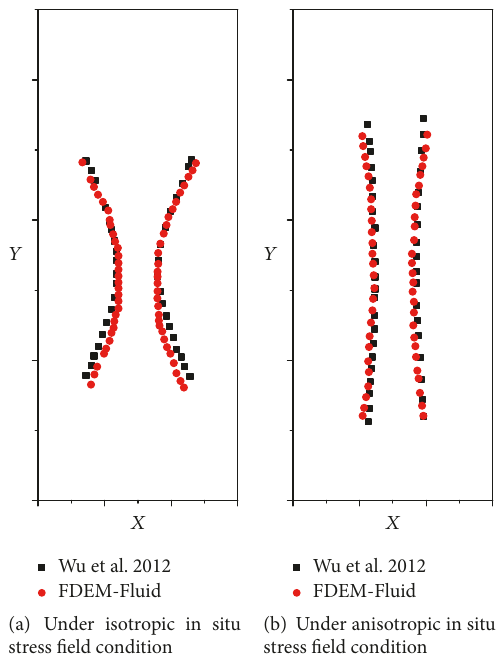
Figure 26: Comparison of propagation paths by FDEM-Fluid and Wu et al. [10].